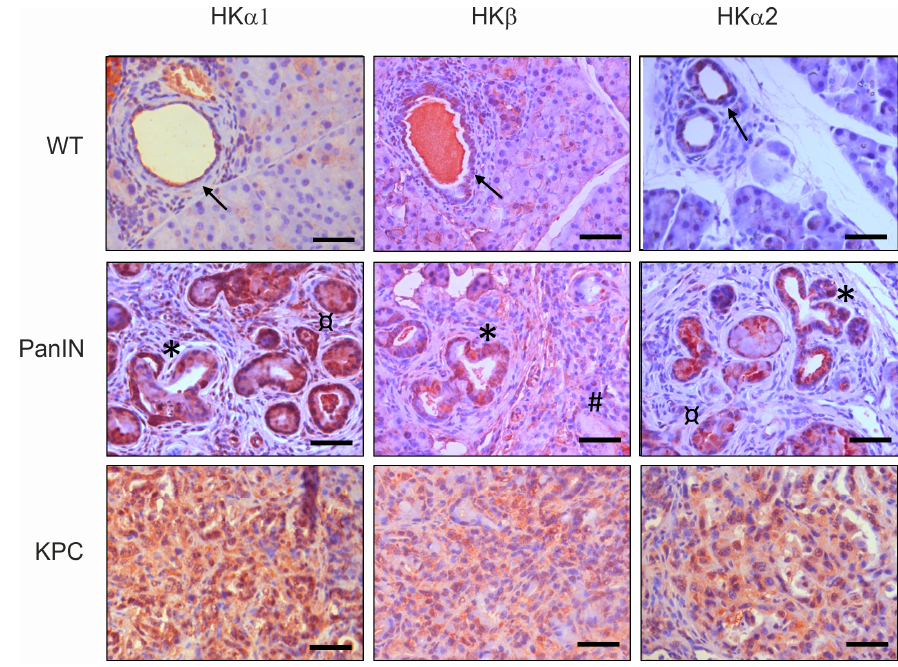
Figure 1. Localization of H + , K + -ATPases subunits in mouse models of pancreatic cancer. Samples